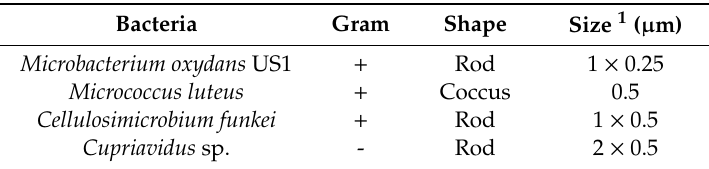
Table 2. Characteristics of the four bacteria studied. Bacteria